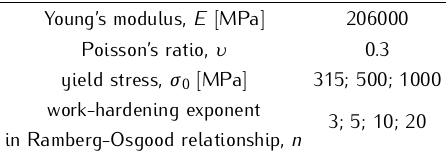
Table 2. The mechanical properties for materials used in numerical